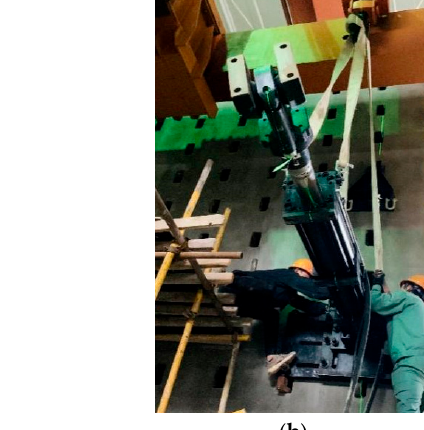
Figure 4. Test loading devices.